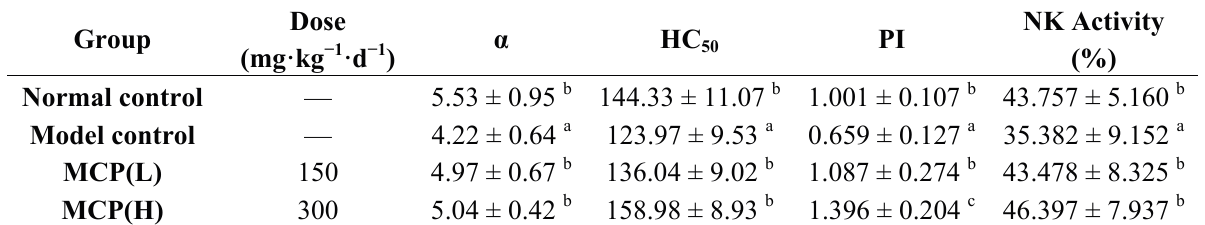
Table 1. Effects of MCP on carbolic particle clearance ( α ), serum haemolysin production (HC ), spleen lymphocyte proliferation and NK cell activity in immunosuppressed 50